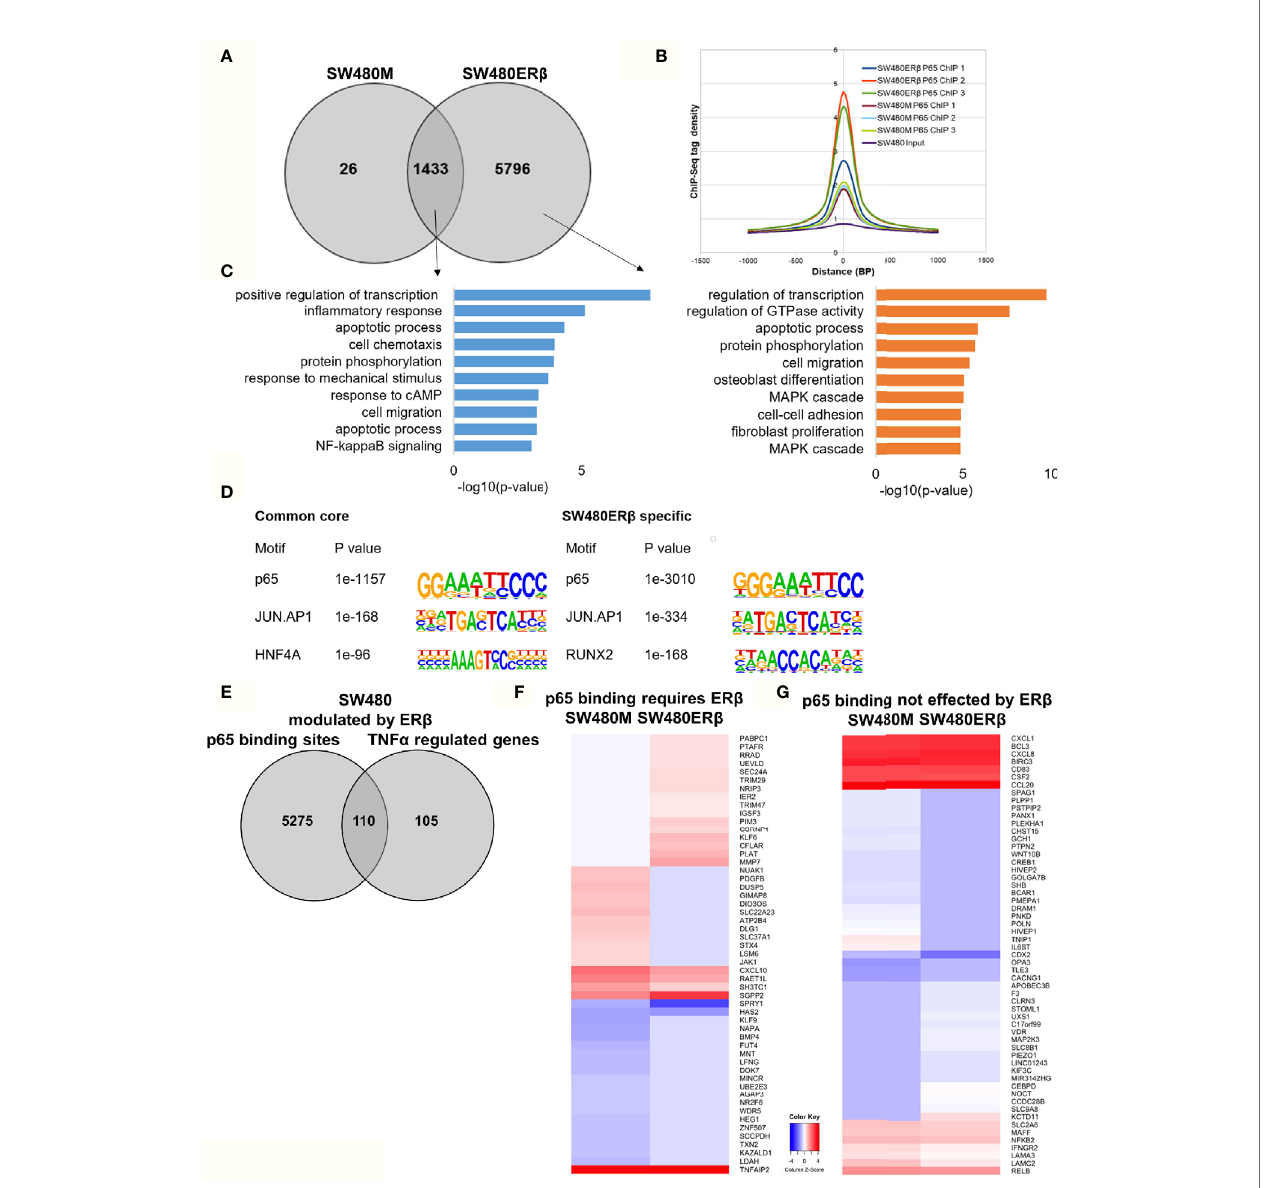
FIGURE 6 | ER b enhances P65 chromatin binding in SW480 cells. (A) Venn diagram of p65 binding sites in SW480 cells with and without expression of ER b . (B) Density plot representing the distribution of p65 tag densities in three replicates each of SW480cells with and without ER b . (C) Biological functions enriched among genes located nearest to p65 binding sites in SW480 cells depending on ER b expression. (D) Motifs highly enriched in p65-bound sequencing in SW480 cells only in absence of ER b , regardless of ER b expression (core genes), and only in presence of ER b , respectively. HOMER was used to identify genomic distribution and motifs of p65 binding sites across the genome. (E) Overlap of genes located nearest to the p65 binding sites and those genes where ER b expression impacted TNF a gene response in HT29 cells. (F, G) Heatmap representing ER b modulation of the TNF a -regulated genes, of genes located nearest to p65 binding that (F) required ER b or (G) was not affected by ER b . Z score values were calculated from the logarithmic fold changes, which represent a value ’ s relationship to the mean of a group of values. A positive Z score indicates the values above the mean and negative if it is below the